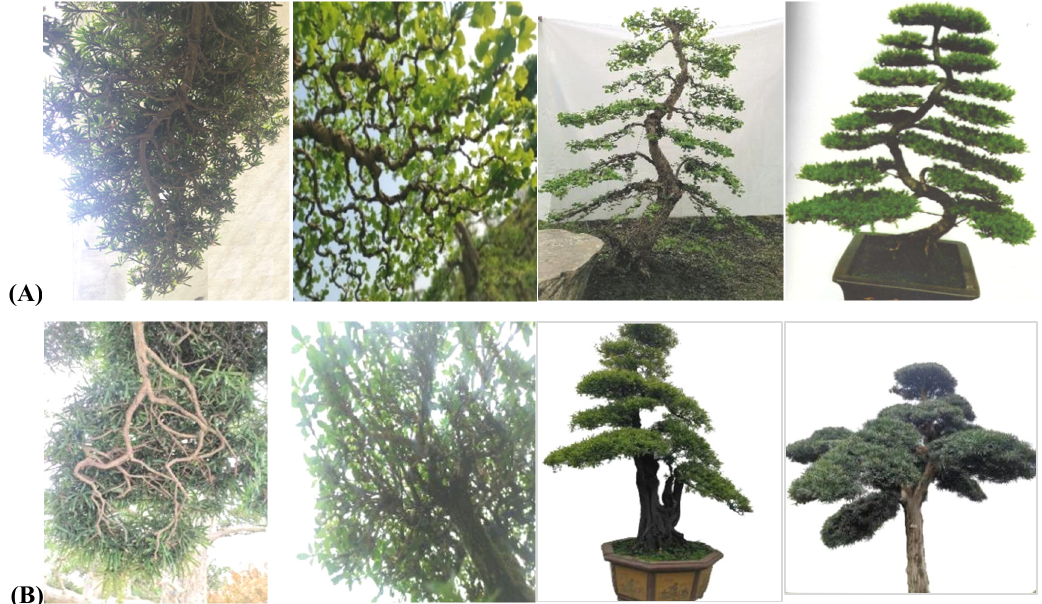
Figure 4. The branch styles of standard ( A ) and nonstandard ( B ) flat-branched types.